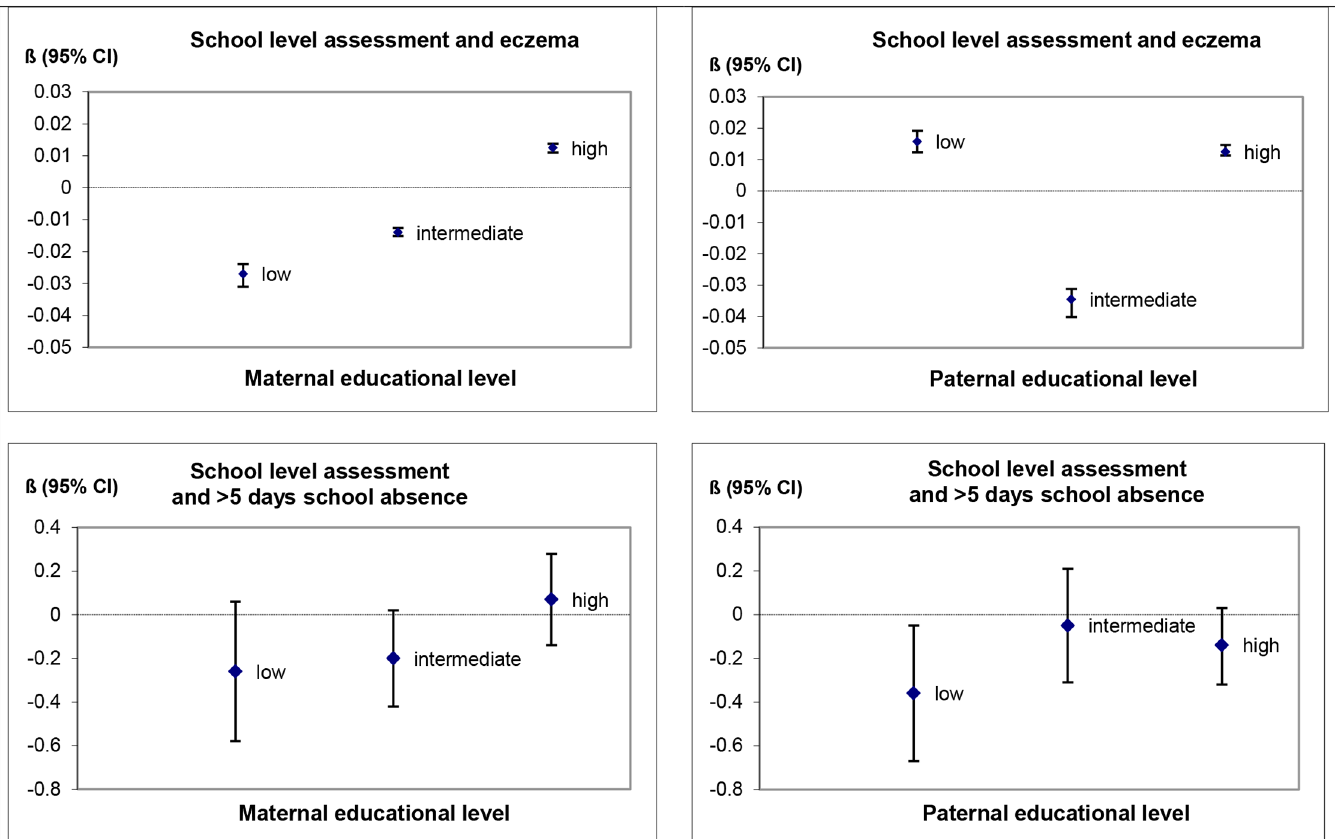
Fig 1. Associations between eczema, health related school absence and school level assessment, stratified by parental education a . a Adjusted for sex of the child.